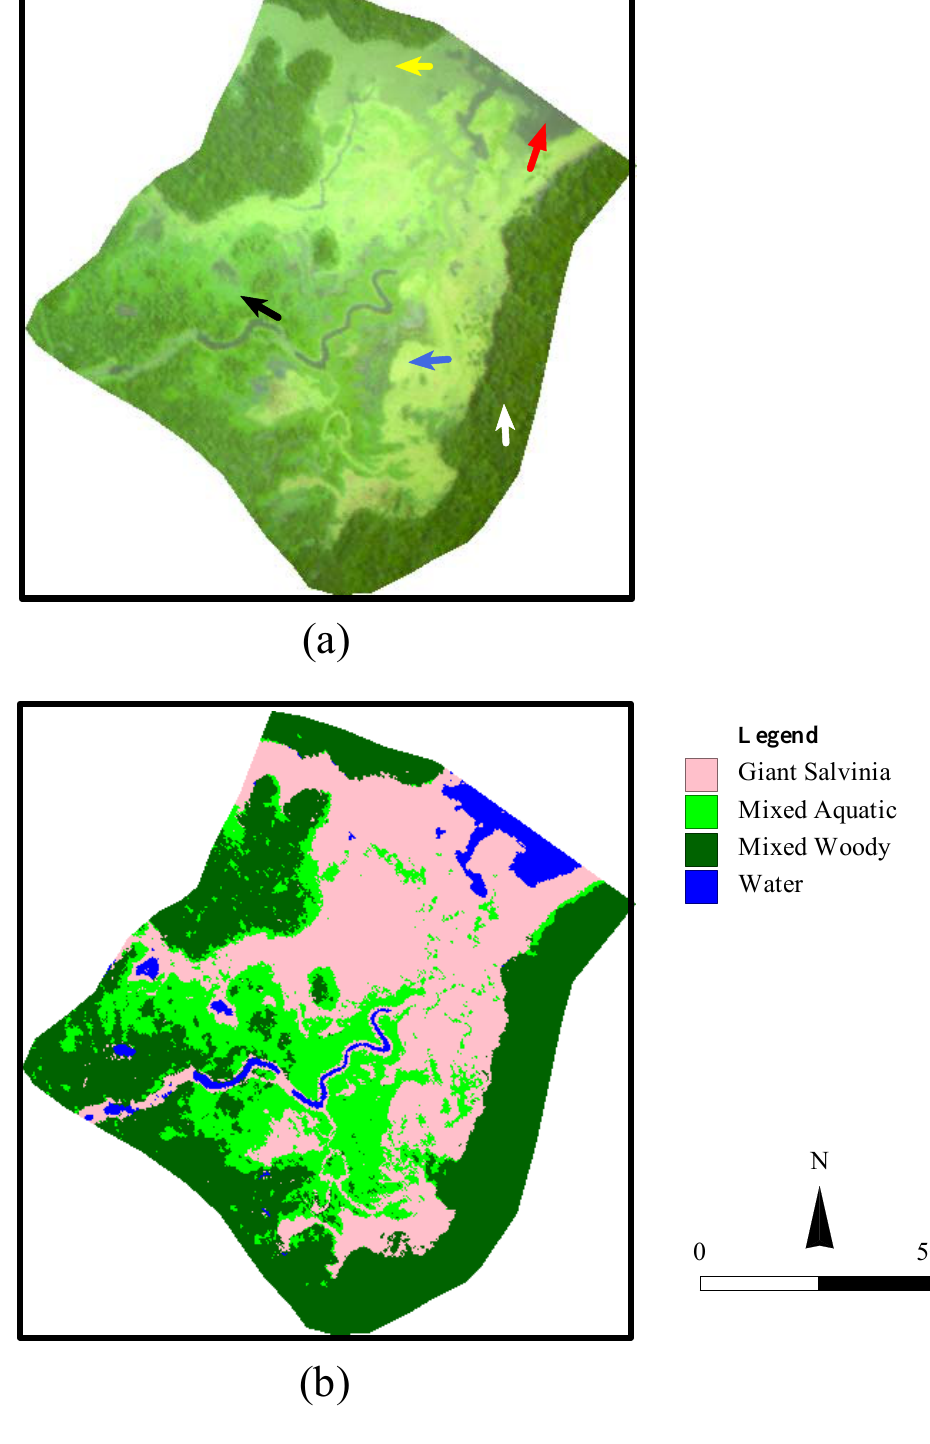
Figure 2. (a) Natural color composite of the study site. Yellow (moderate plant cover (50–75%)—surface was a mixture of water and giant salvinia) and blue (high plant cover—giant salvinia completely masked out water surface) arrows-giant salvinia, white arrow—mixed woody vegetation, black arrow—mixed aquatic, and red arrow—water. (b) Thematic map of giant salvinia infestation at the study. Map was derived from five-band (blue, green, red, near-infrared, and mid-infrared) composite image of the study